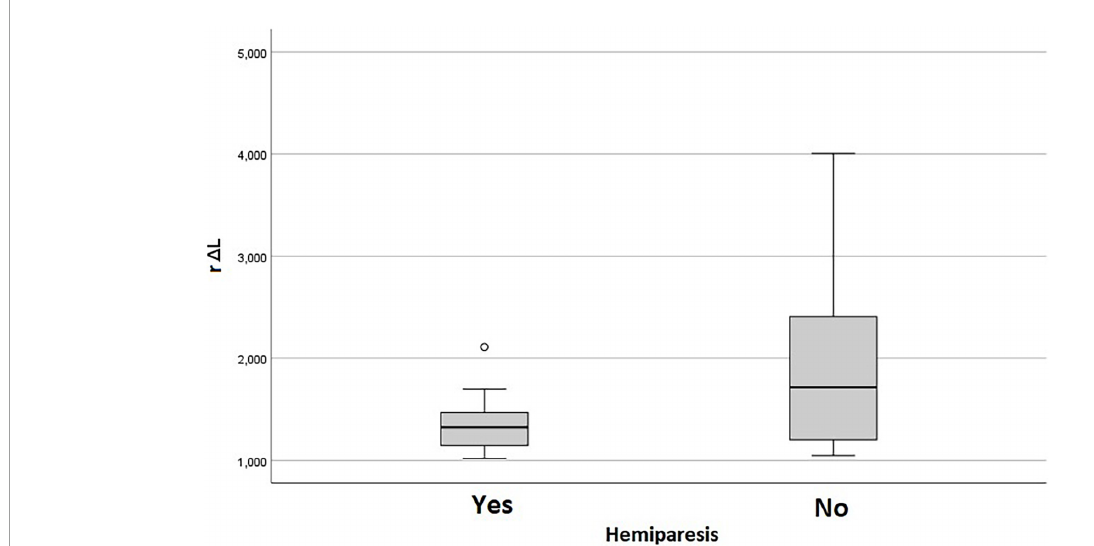
FIGURE2 Box plot graph of r (cid:49) L and hemiparesis.